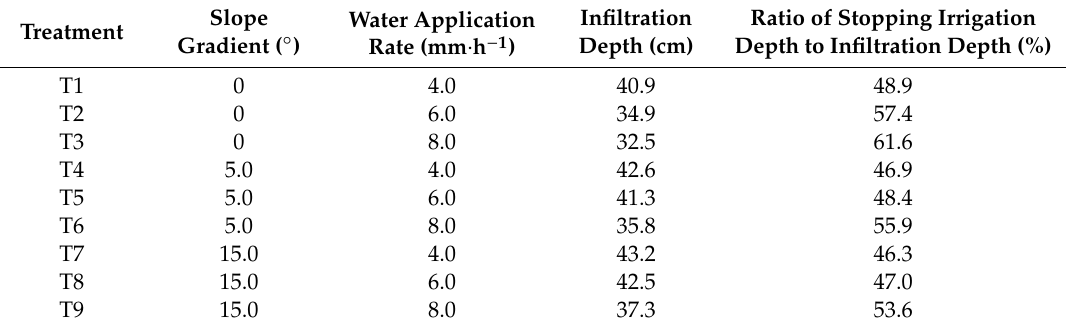
Table 4. The ratios of di ff erent slope gradients and water application